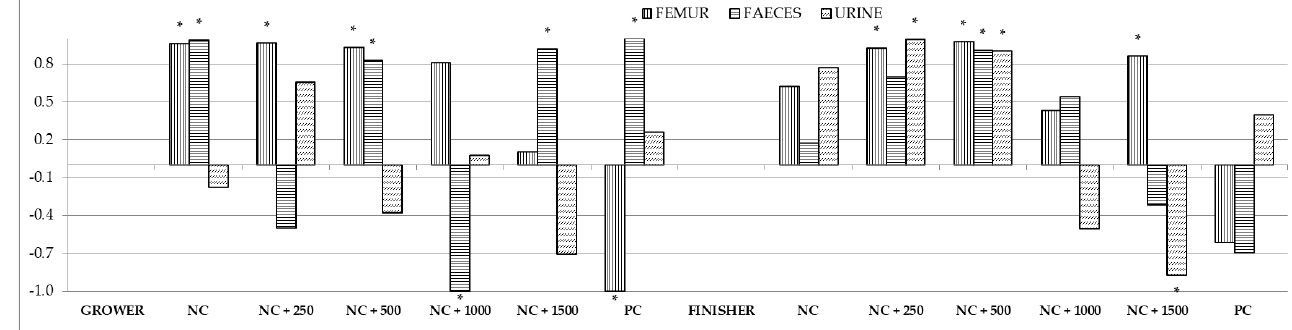
Figure 4. Correlations between content of calcium in the blood and in the femur, feces, and urine. Asterisks indicate significant correlations at p < 0.05.